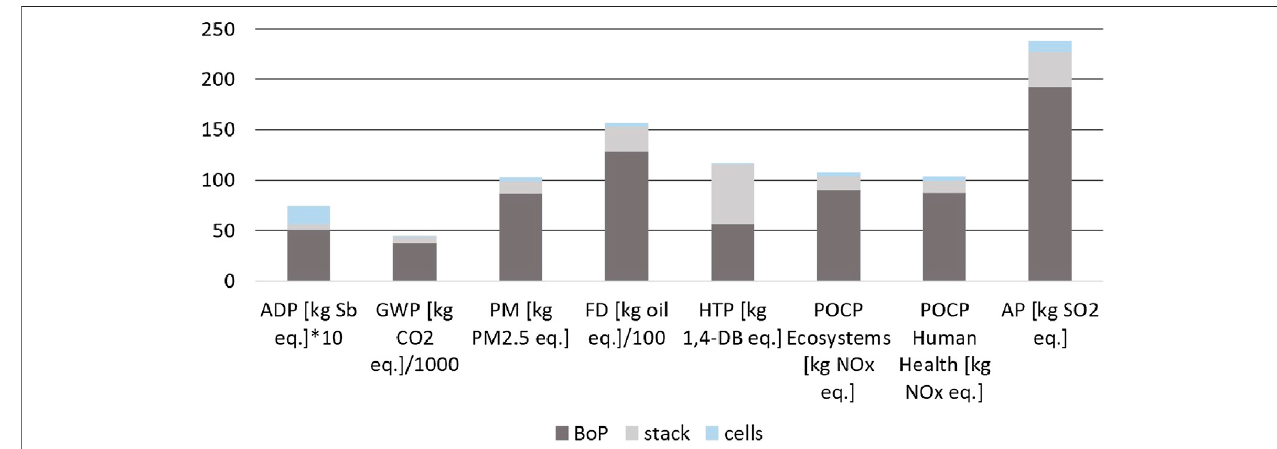
FIGURE 6 | Environmental impacts of the HT-co-electrolysis subdivided in BoP, stack and single cells.